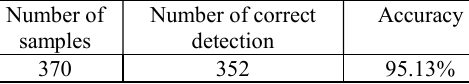
Table 9 Confusion matrix after removing spurious